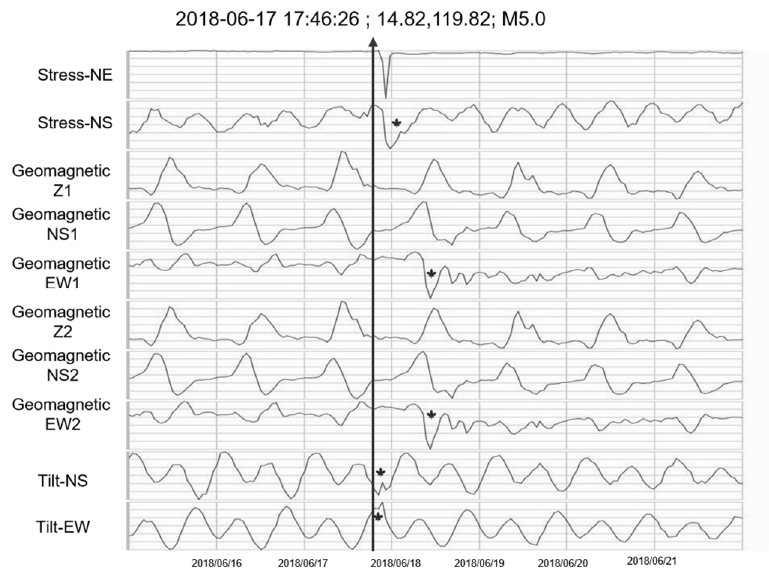
Figure 5. The magnified records of some parameters in Figure 4: the two stress components, six geomagnetic field components, and two earth tilt components.